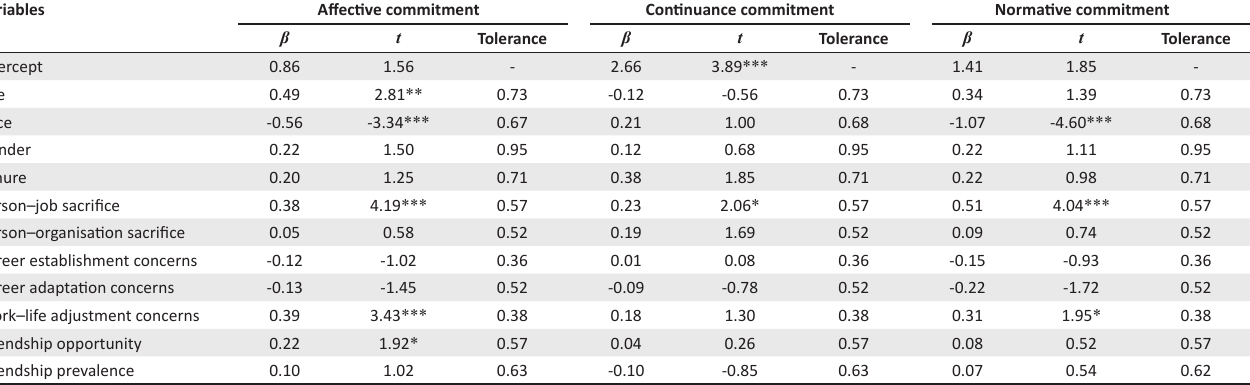
TABLE 2: Multiple regression